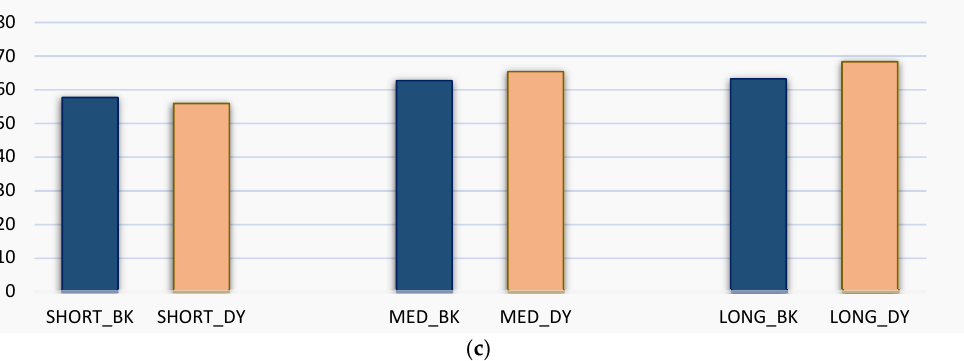
Figure 5. Side-by-side comparison of return spillover based on BK18 and wavelet-based DY12 methods: ( a ) Return To; ( b ) Return From; ( c ) Total Return. The y-axis denotes return spillovers. The x-axis description is as follows: Short_BK, Med_BK, and Long_BK are within spillover indexes calculated using the BK18 method for the short-, medium-, and long-term. Short_WAV, Med_WAV, and Long_WAV are spillover indexes calculated using the DY12 method from wavelet-based series for the short-, medium-, and long-term. Total return is the total return spillover between the two mentioned methods.